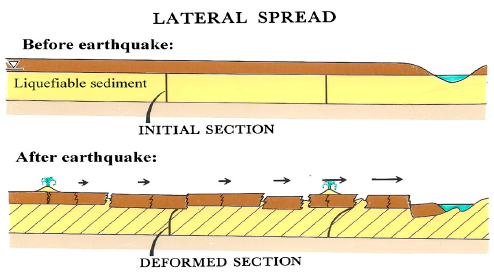
Figure 1. Liquefaction mechanism: soil particles floating due to the increment of pore water pressure